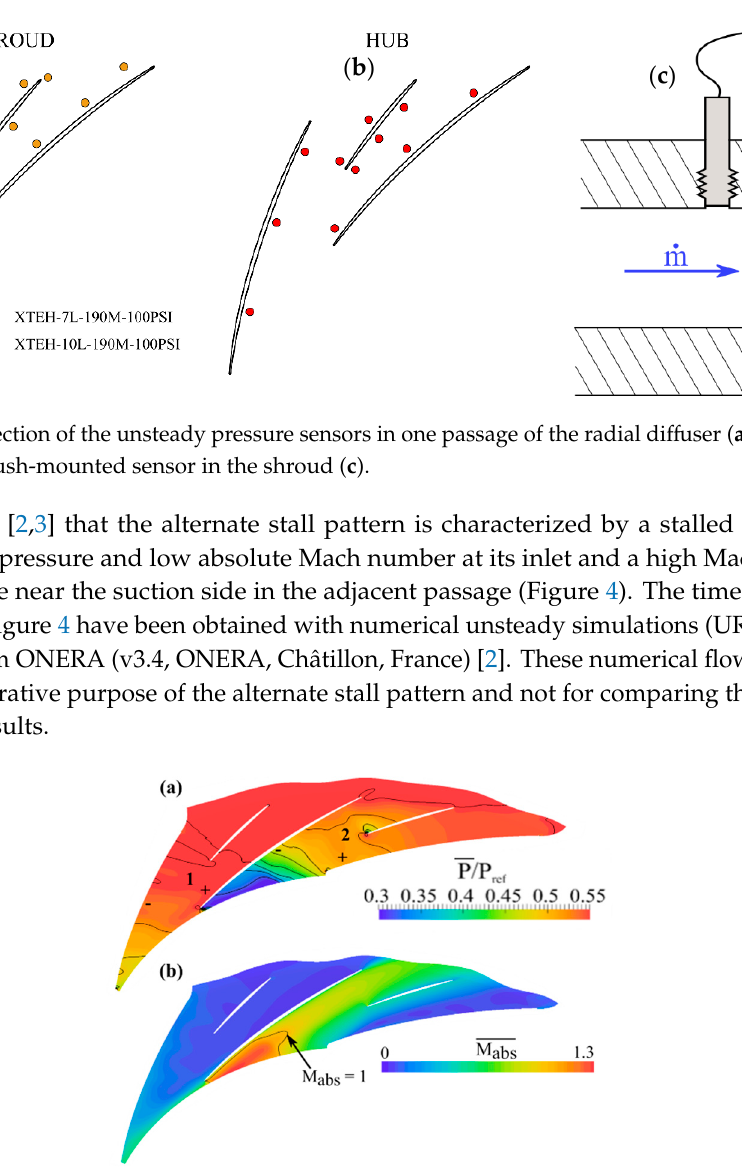
Figure 4. ( a ) Mach number and ( b ) static pressure fields in the radial diffuser obtained by numerical simulation.